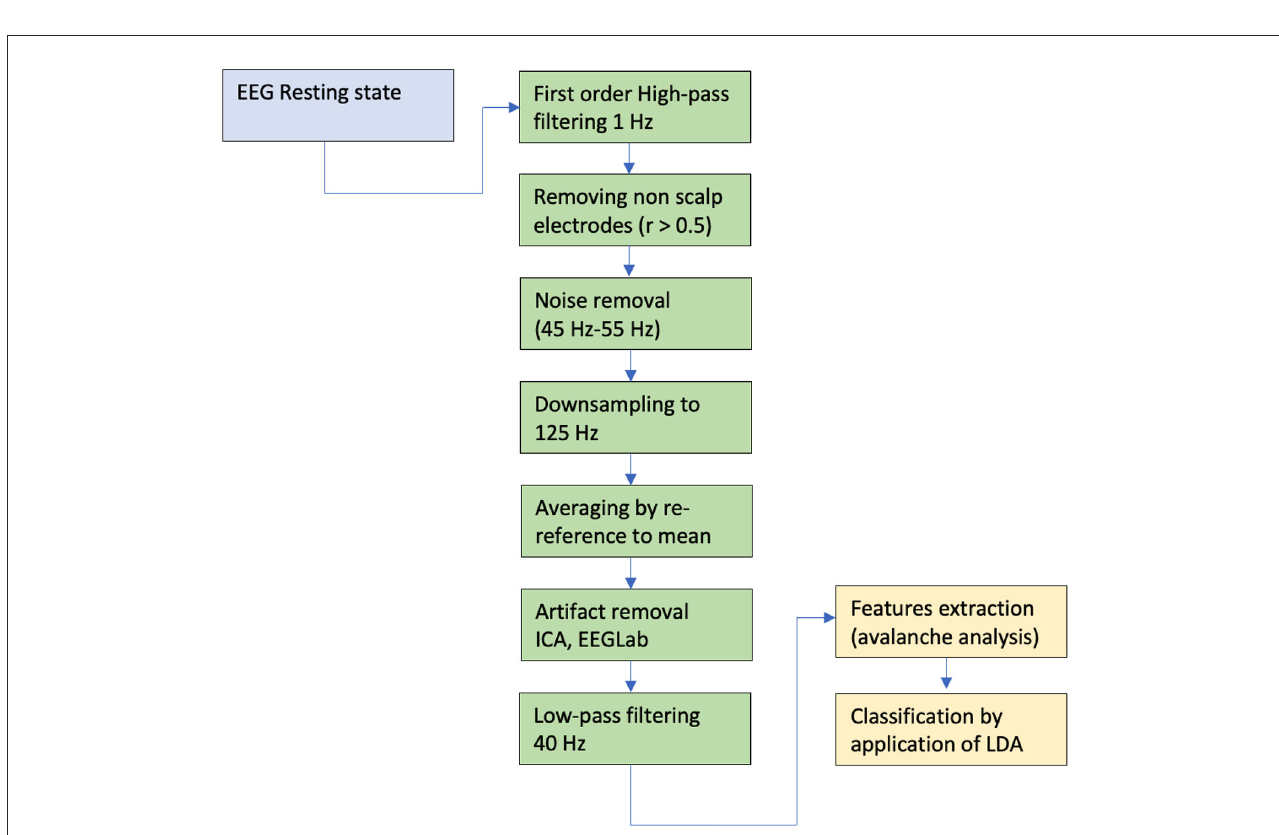
FIGURE3 Data analysis pipeline for the resting state. For detail see the